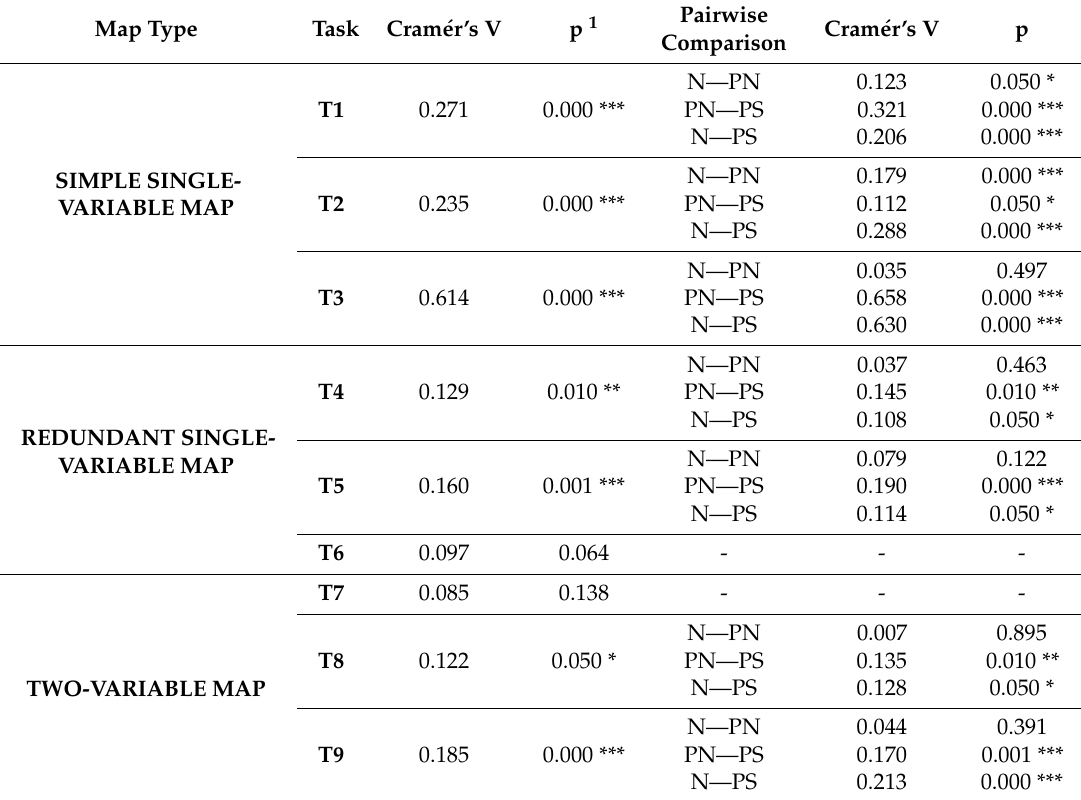
Table 3. Methods and the correctness of